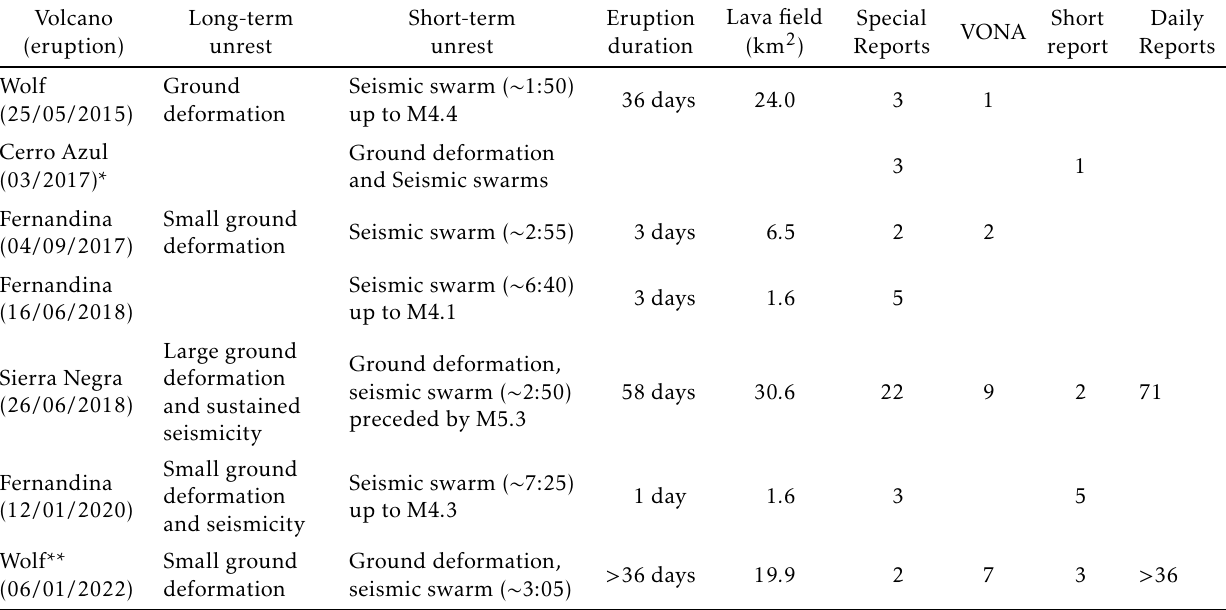
Table 1: Summary of recent volcanic events in the Galápagos Islands and communication products. M = Mag- nitude. Ground deformation is mostly detected by InSAR, except for Sierra Negra where GPS networks are also used.